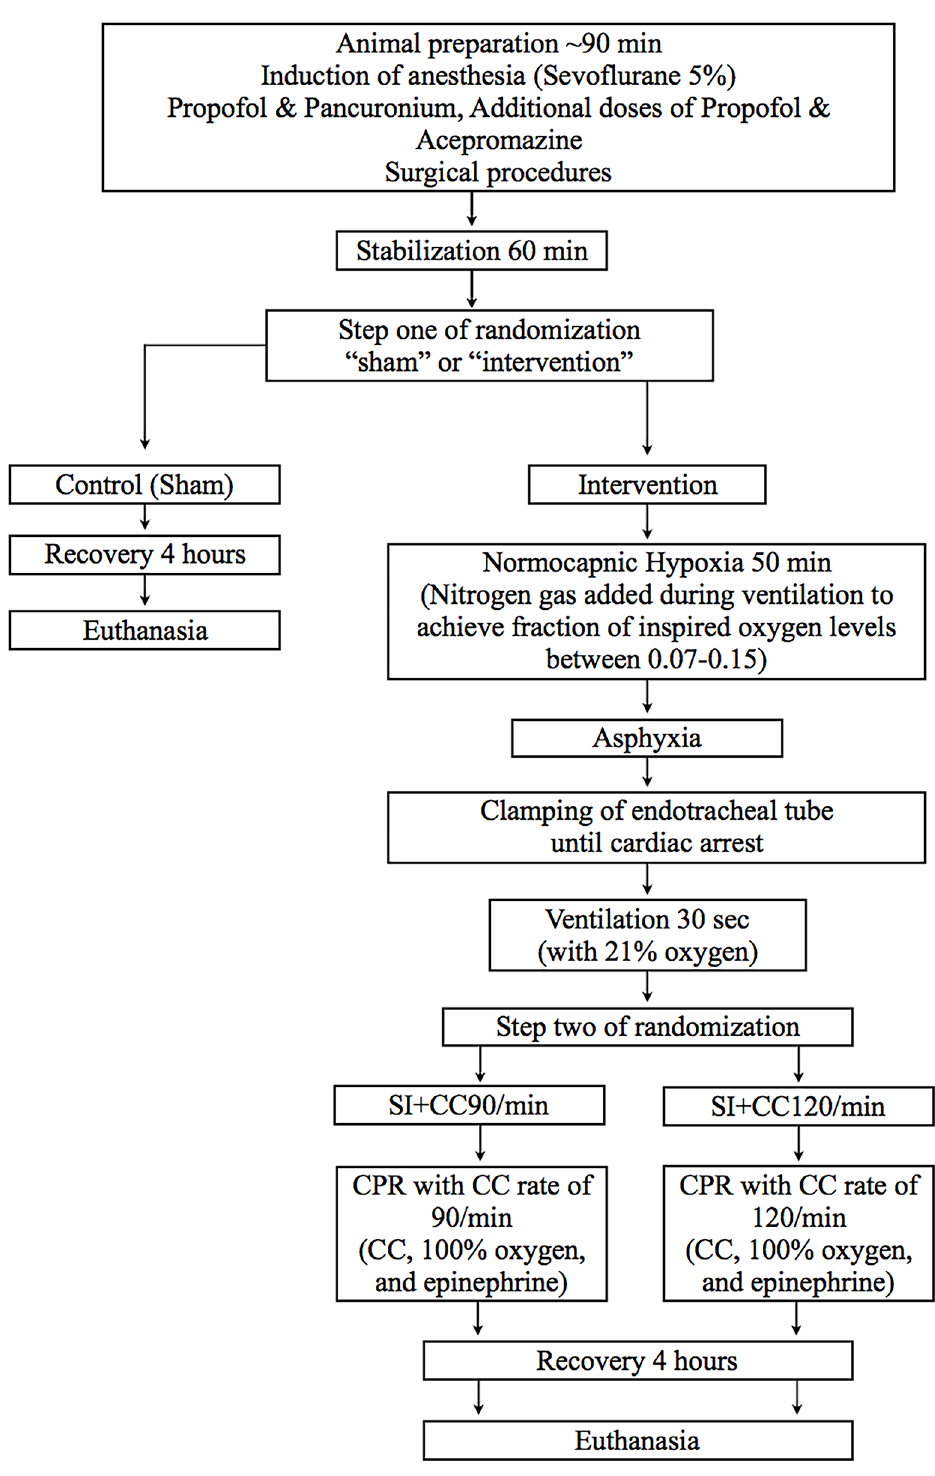
Fig 1. Study flow chart.